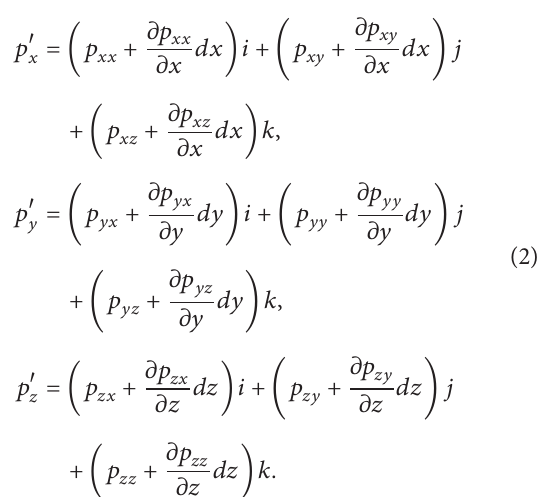
Figure 1: Fluid micelle force